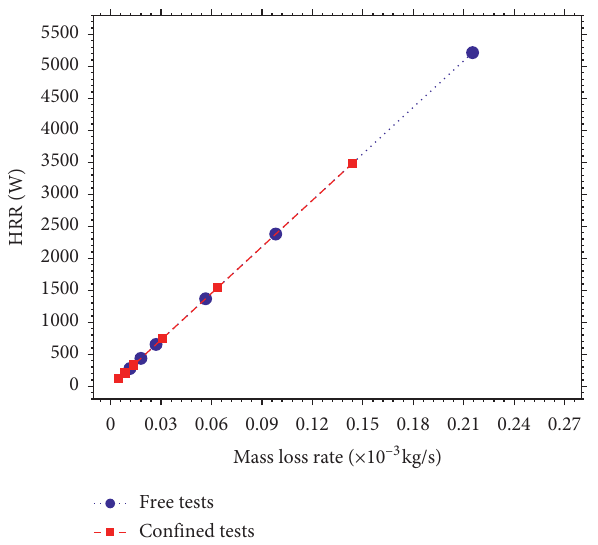
Figure 14: Variation of the heat release rate in open and confined surroundings.